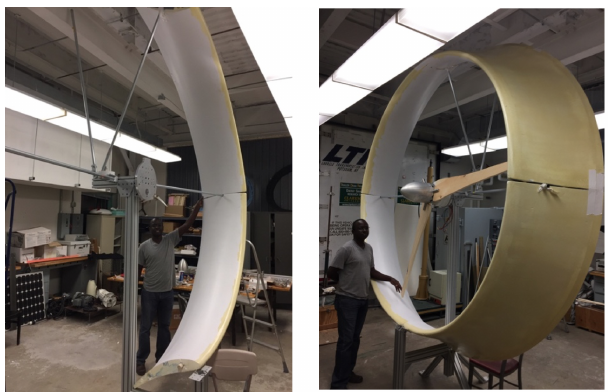
Figure 9. Construction of duct at Clarkson University.